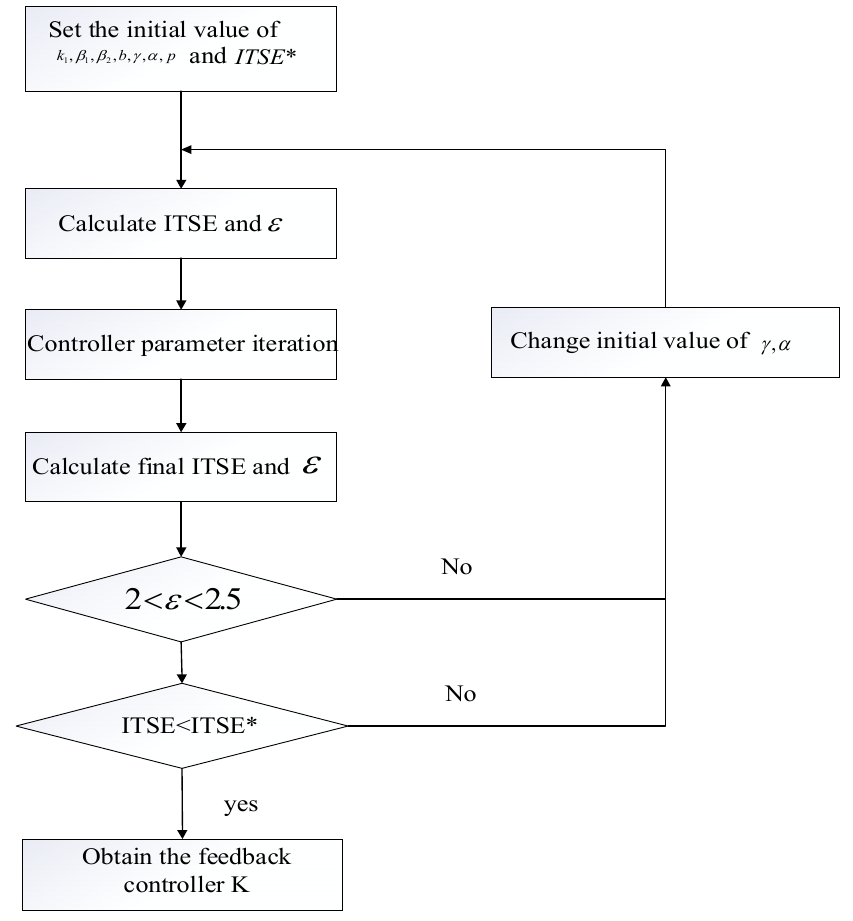
Figure 6. The process of optimizing the parameters of first-order LADRC by ES.